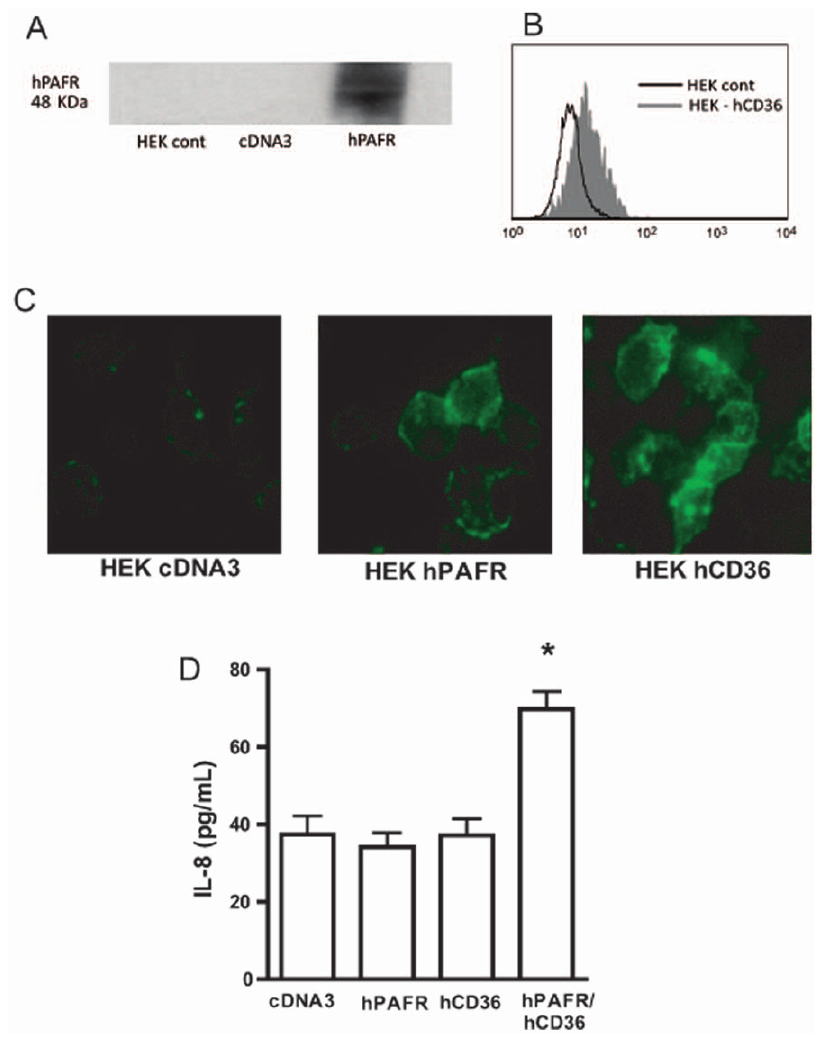
Figure 6. CD36 and PAFR cooperatively mediate FITC-oxLDL uptake and IL-8 production. HEK 293t cells were transiently transfected with hCD36 and/or hPAFR, as described in methods (A–B). Transfected cells were incubated with FITC-oxLDL (30 m g/mL) for 1 h at 37 u C. Cells were washed and fixed with paraformaldehyde 4%. Fluorescence was visualized by microscopy (C). Transfected cells were stimulated with oxLDL (30 m g/mL) and the IL-8 concentration in the supernatant was measured after 24 h (D). * p , 0.05 comparing with cDNA3 plasmid control transfected